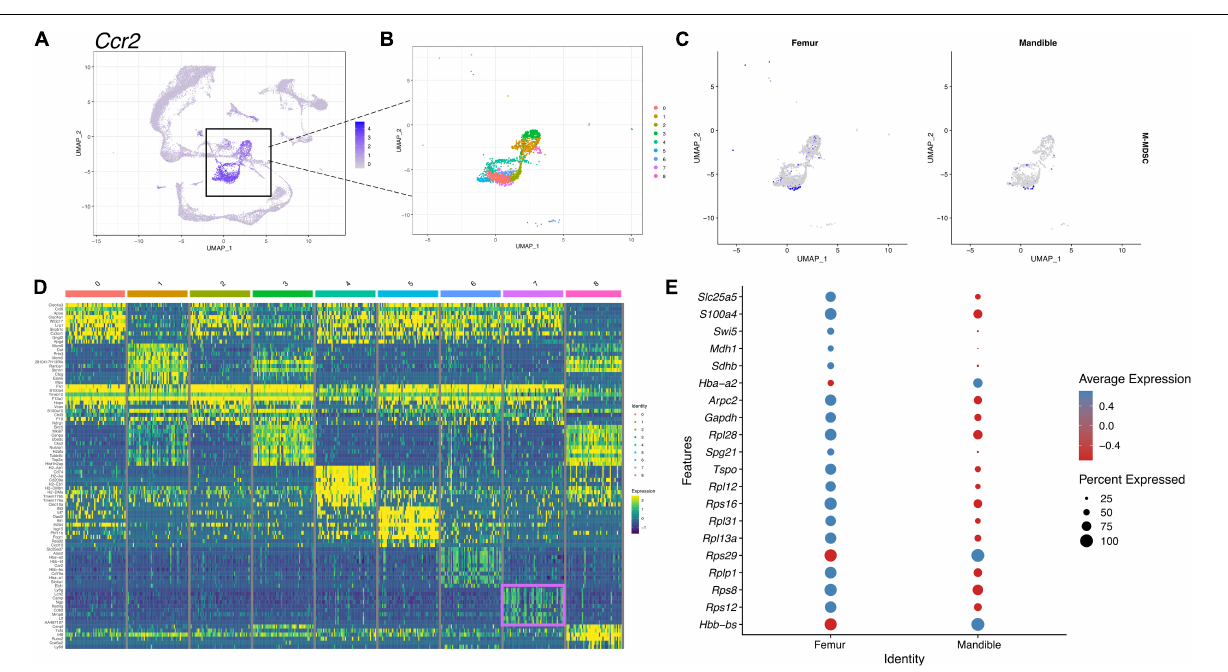
FIGURE 7 | scRNA-seq of M-MDSCs in mBM reveals a transcriptional profile distinct from M-MDSCs in fBM. (A) M-MDSCs were identified as a subpopulation of the monocyte cluster marked by Ccr2 expression. (B) The monocytic population was broken into nine distinct clusters. (C) Feature plots showing the M-MDSC composite score in femur and mandible. (D) The top ten most highly expressed genes in each cluster displayed in a heatmap showing expression on a log scale. The M-MDSC cluster seven genes are boxed in pink. (E) The top 20 differentially expressed genes in cluster 7 comparing the femur and mandible displayed in a dotplot, showing M-MDSC transcriptomic differences between the two anatomical locations.